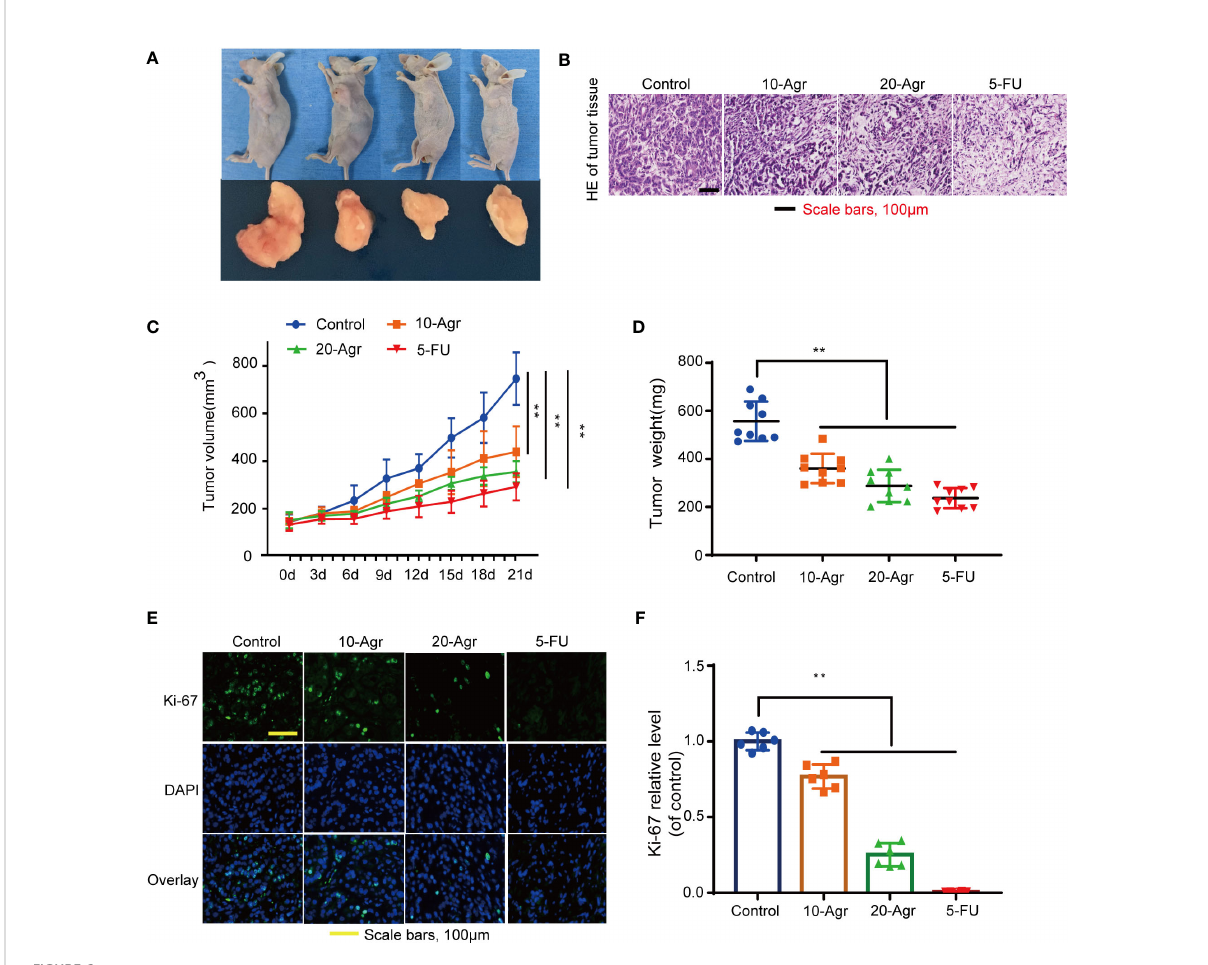
FIGURE 6 Agr inhibited the progression of colon cancer in vivo . 10-Agr represents Agr 10 mg/kg (i.p., QD), 20-Agr represents Agr 20 mg/kg (i.p., QD), and 5-FU represents 5-FU 5 mg/kg (i.p., QD). (A) A subcutaneous tumor model shows smaller tumors in Agr-treated groups than in the control group ( n = 9, each group). (B) Representative micrographs showing tumor tissue by hematoxylin and eosin staining. (C) The volume of subcutaneous tumors following abdominal administration of drug ( n = 9, each group). (D) Quantitative data of tumor weight ( n = 9, each group). (E) Representative micrographs showing tumor tissue by Ki-67 fl uorescent staining. (F) Quantitative data of Ki-67 fl uorescent staining ( n = 6). ** p < 0.01 versus control. Scale bars = 100 m m. Agr, agrimol